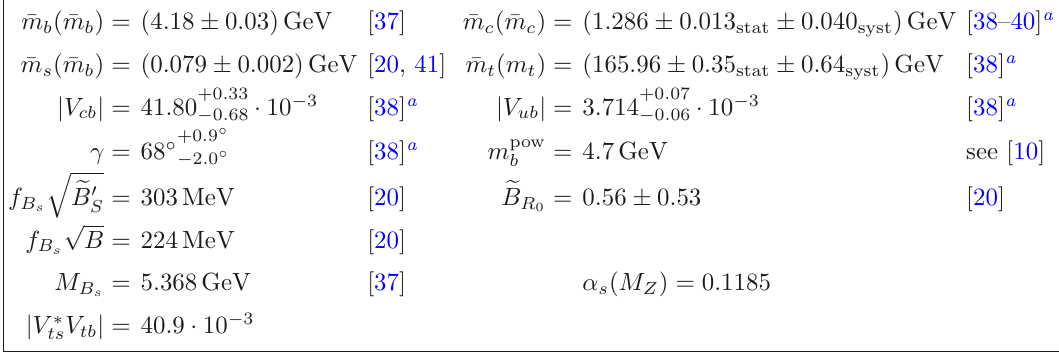
Table 1 . Input parameters used in section 5. ¯ m 0 . 001 GeV [41]. m pow B